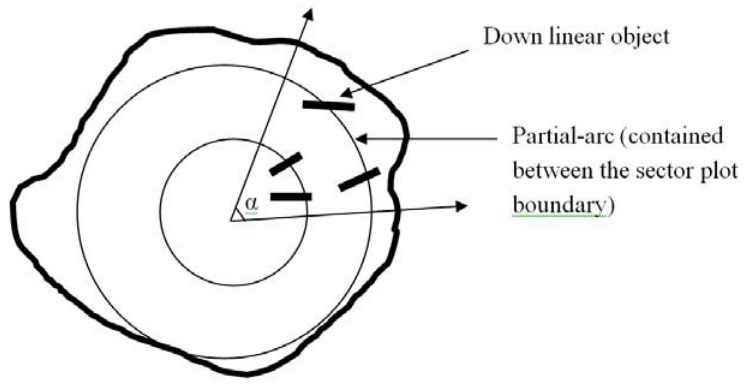
Figure 4. Sampling down objects using sector plots: a systemic location of two partial-arcs with a random start is shown; α is the internal sector